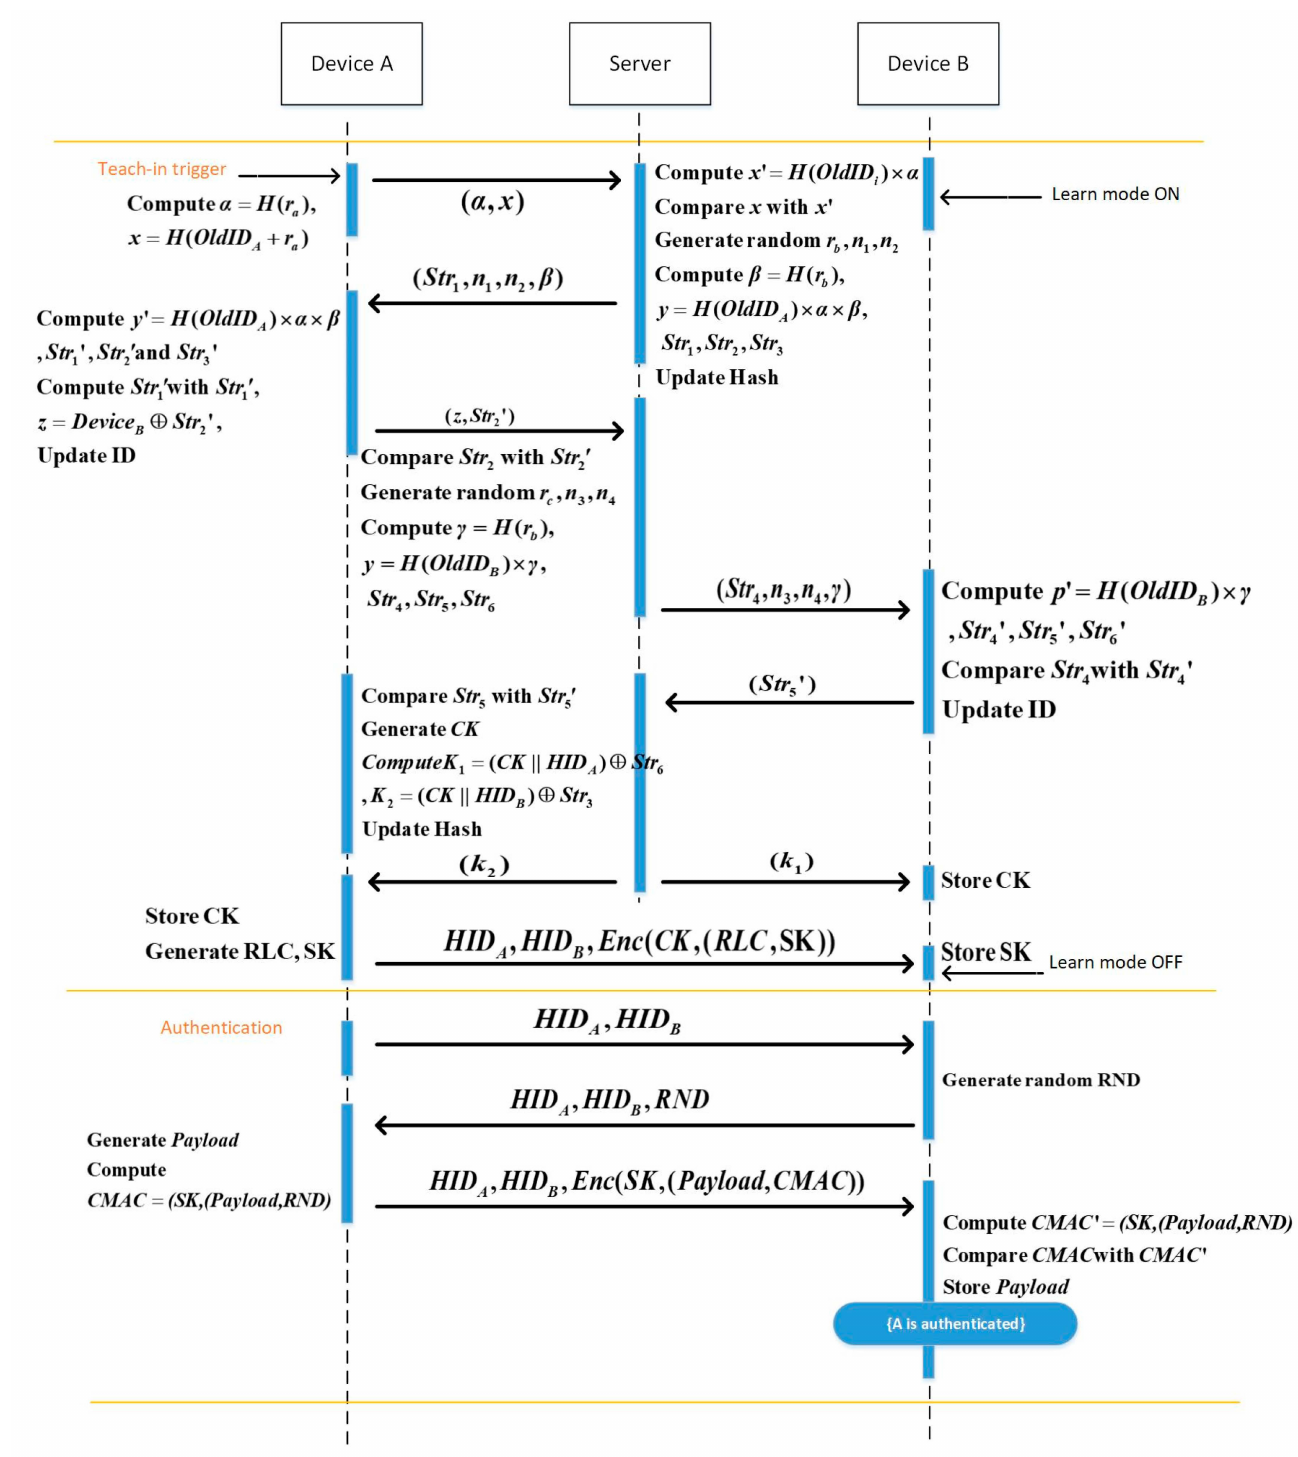
Figure 10. EnOcean-A protocol data